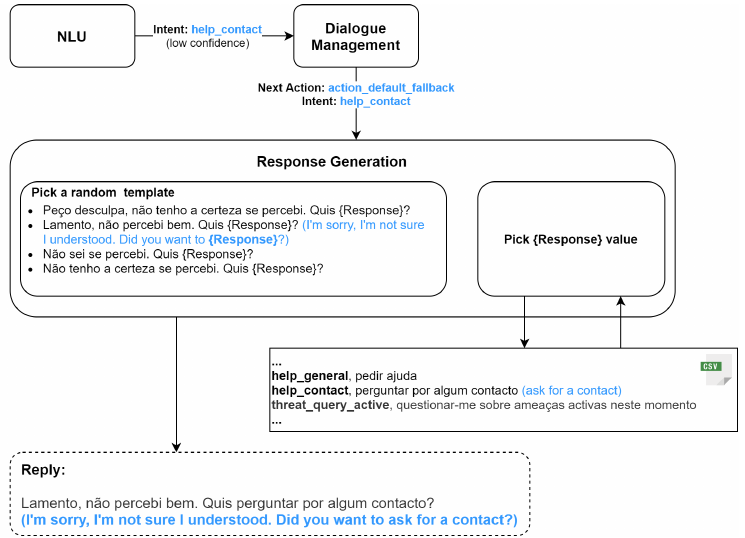
Figure 4. Building the first reply of a Fallback